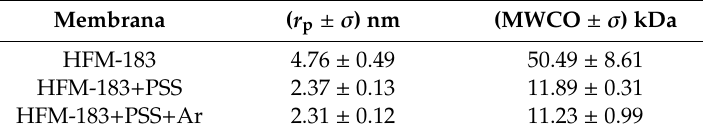
Table 3. Pore radii and MWCO according to LLDP.